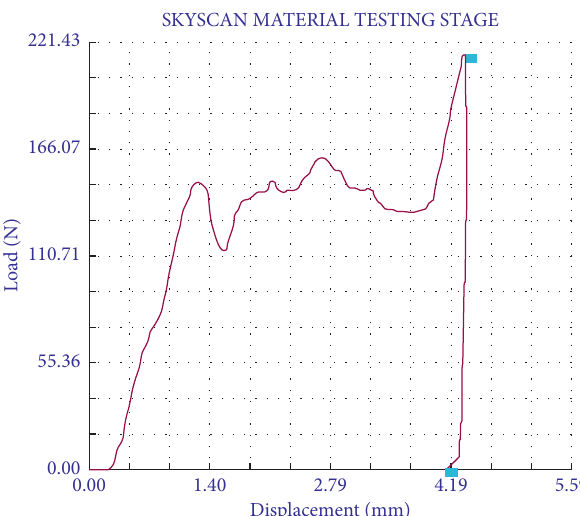
Figure 5: Mechanical behavior of the composite under load (in Newtons) plotted vs. distance (in